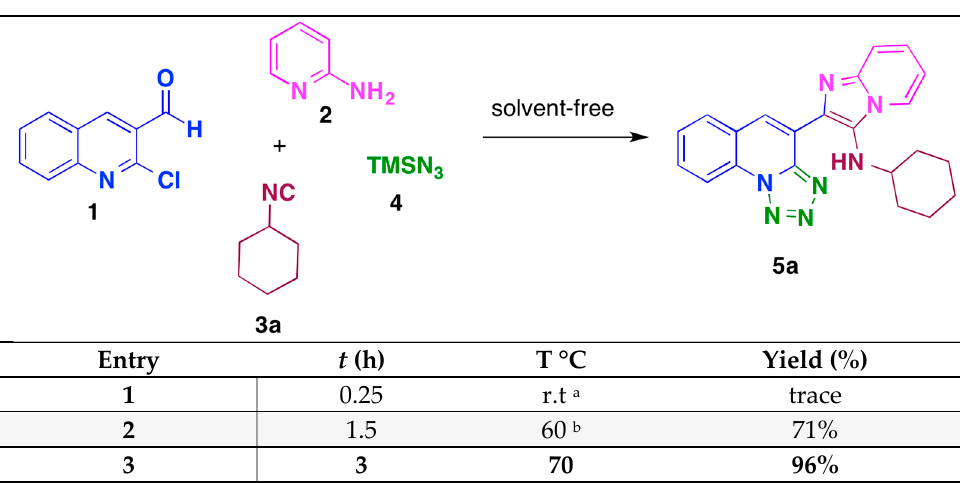
Table 1. Screening